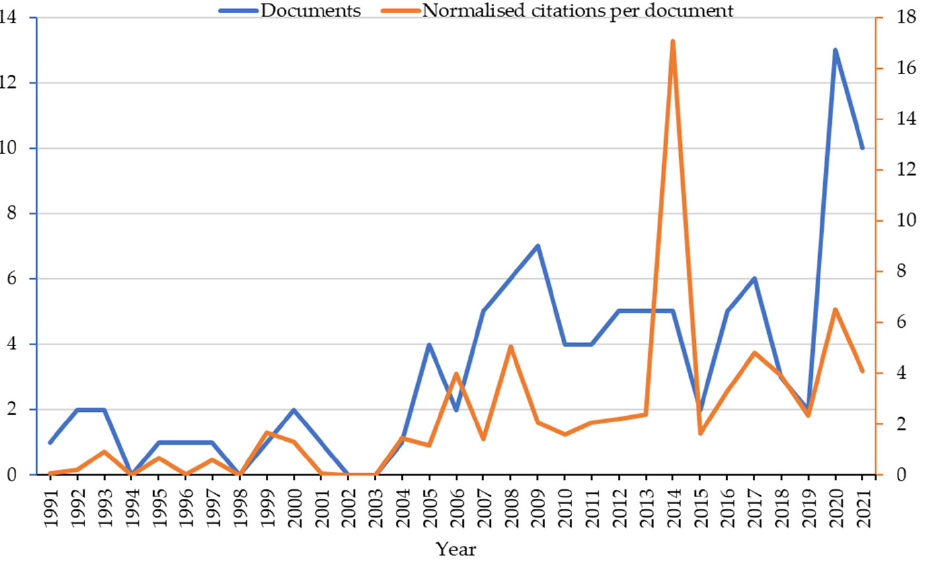
Figure 3. Evolution of main bibliographic indices throughout the years. The number of documents is in blue and the normalized average number of citations per document in orange.